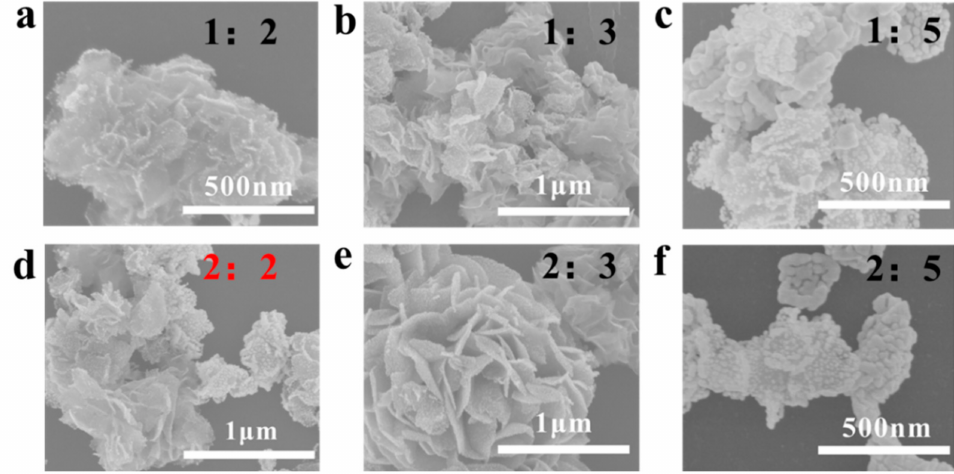
Figure A3. SEM images of MoS 2 /Au obtained from MoS 2 and chloroauric acid at different addi- tion